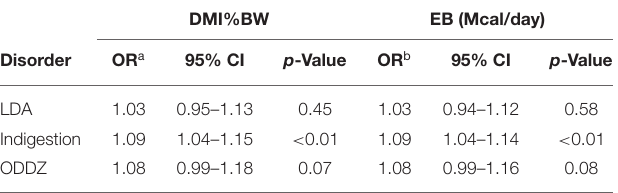
TABLE 3 | Effect of the average DMI as a percentage of body weight (DMI%BW) and the average energy balance (EB) in the last 3 days prepartum on postpartum left displaced abomasum (LDA), indigestion, and other digestive disorders in the first 28 days